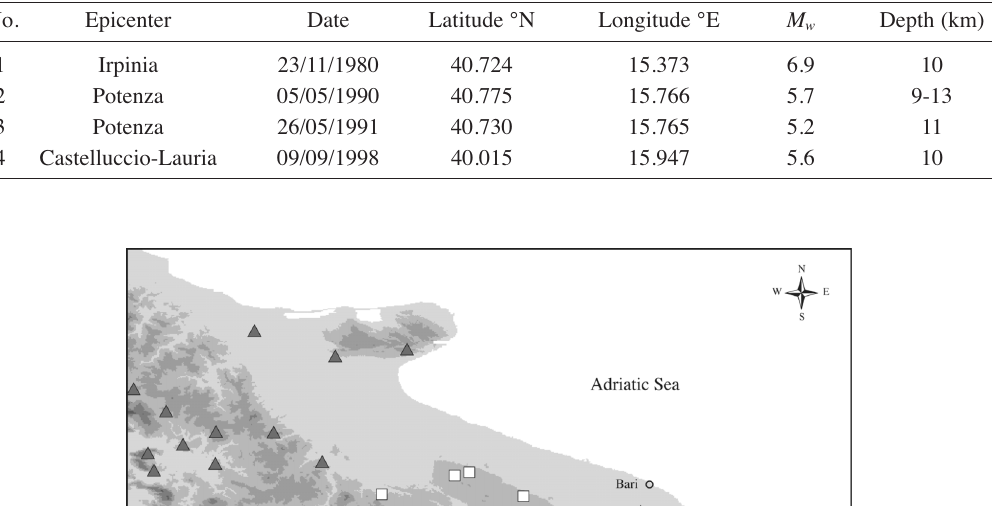
Table I. Parameters of the largest instrumental earthquakes in the Southern Apennines (parameters of the Ir- pinia event are from Amato and Selvaggi (1993), of the two Potenza earthquakes are from Ekström (1994), of the Castelluccio-Lauria are from Harvard CMT Catalogue). The CMT (Centroid Moment Tensor) solutions of these earthquakes are shown in fig. 1, except for the unavailable mechanism of event no. 3. No.